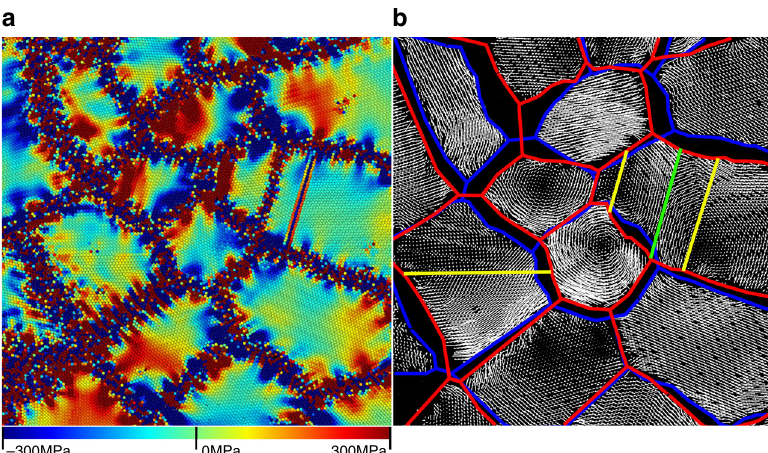
Fig. 2 Stress generation and lattice rotation in MD polycrystalline grain growth. A small region of an xy cross-section of the simulation shown in Fig. 1 at 1.25 ns. a σ xy showing large accumulations of stress (dark blue and dark red regions) inside grains. Stresses along GBs re fl ect the local GB structure and are not pertinent to this discussion. b Displacement vectors depicting the motion of atoms between 1.0 and 1.25 ns after initial relaxation. Red and blue lines indicate GB positions at 1.0 and 1.25 ns. Yellow and green lines indicate coherent twin boundaries and stacking faults. Lattice rotations (cyclic displacement vector patterns) and translation (large regions of parallel displacement vectors) are both apparent. Atoms with very large displacements (such as where the GB migrated) were removed for